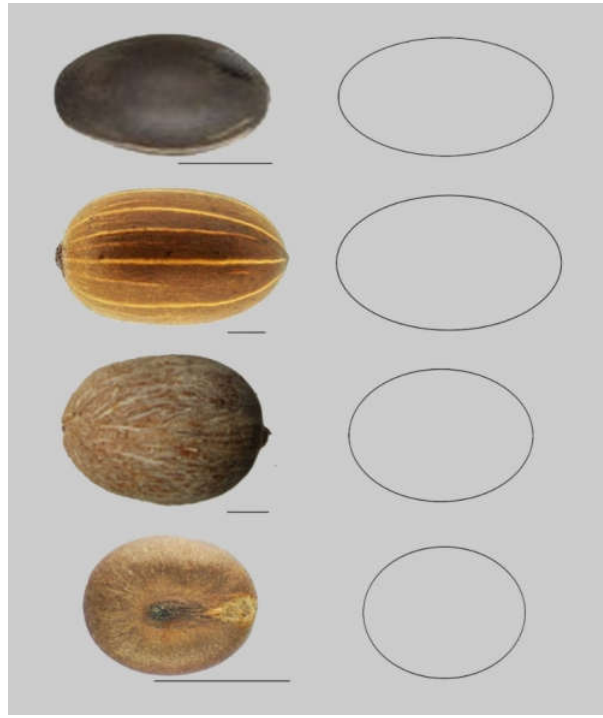
Figure 5. Representative examples of elliptic seeds with their respective models ( J index values are indicated between parentheses): Iriartella sp. (94.4), Socratea exorrhiza (91.6), Adonidia merrillii (92.0), and Washingtonia filifera (91.9). The seed of W. filifera (bottom) is oriented with the attachment of the peduncle in a frontal position while in the other three seeds the attachment of the peduncle is in a lateral position. Aspect ratio values for the ellipses are (from top to bottom): 1.8, 1.7, 1.4, and 1.2. Bars represent 0.5